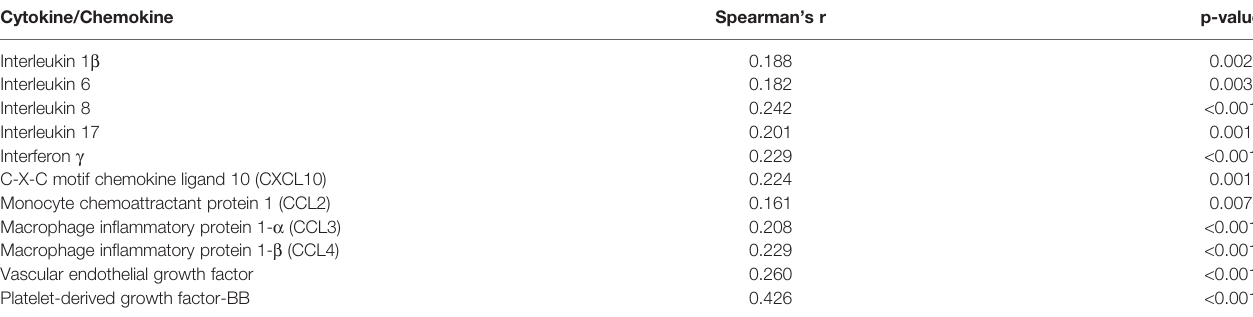
TABLE 5 | Cytokines and chemokines involved in the pathogenesis of IIM and their correlation to plasma Hsp90 based on the bivariate analysis in all IIM patients (n=277).